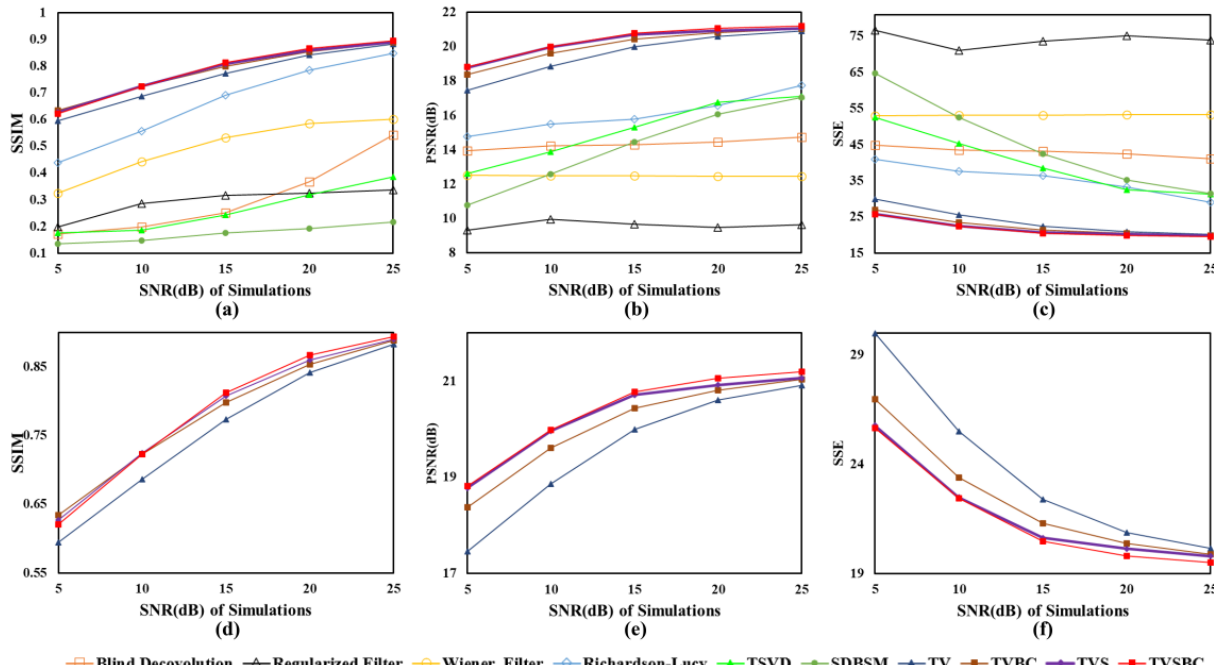
Figure 14. Different evaluation results of deconvolution methods under different SNRs. ( a – c ) PSNR, SSIM, and SSE for deconvolution methods, respectively. ( d – f ) Zoomed-in ( a – c ) for TV-based methods without and with bias correction, respectively.